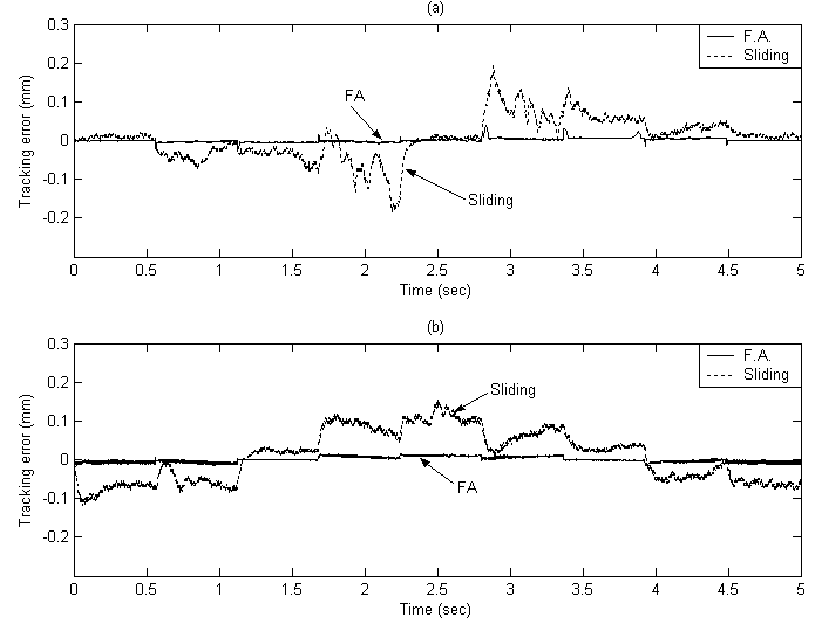
Figure 10. The tracking error of (a) X axis and (b) Y axis (case